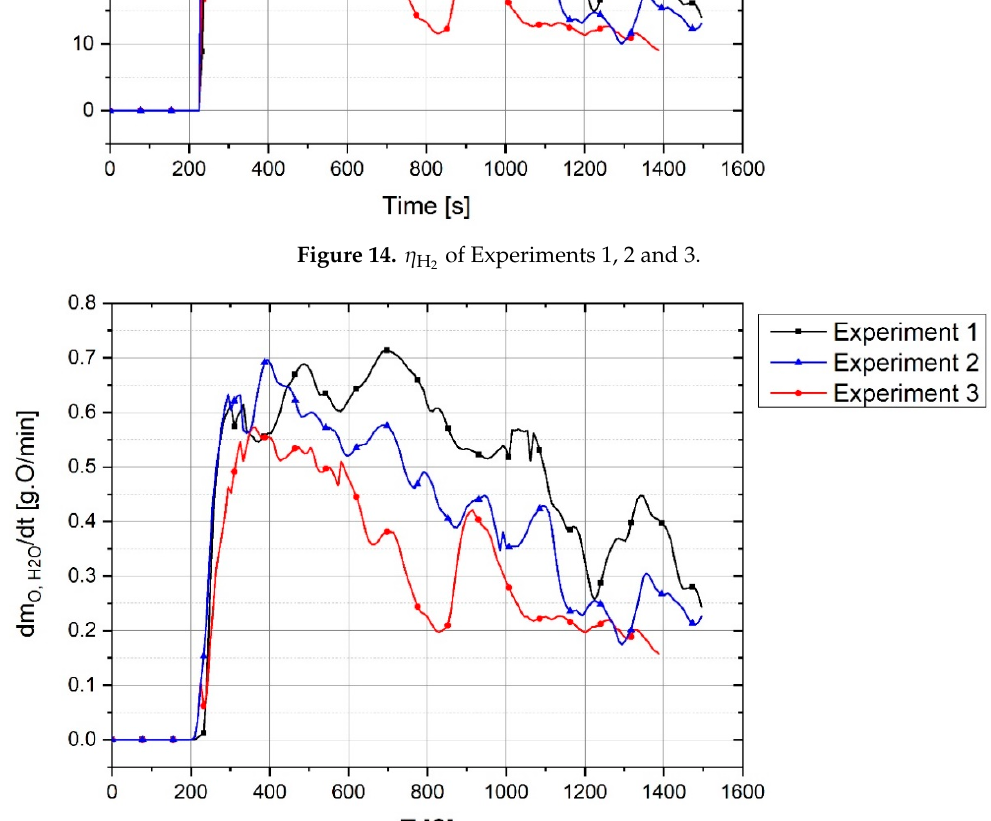
Figure 15. Reduction rate by hydrogen in Experiments 1, 2 and 3.